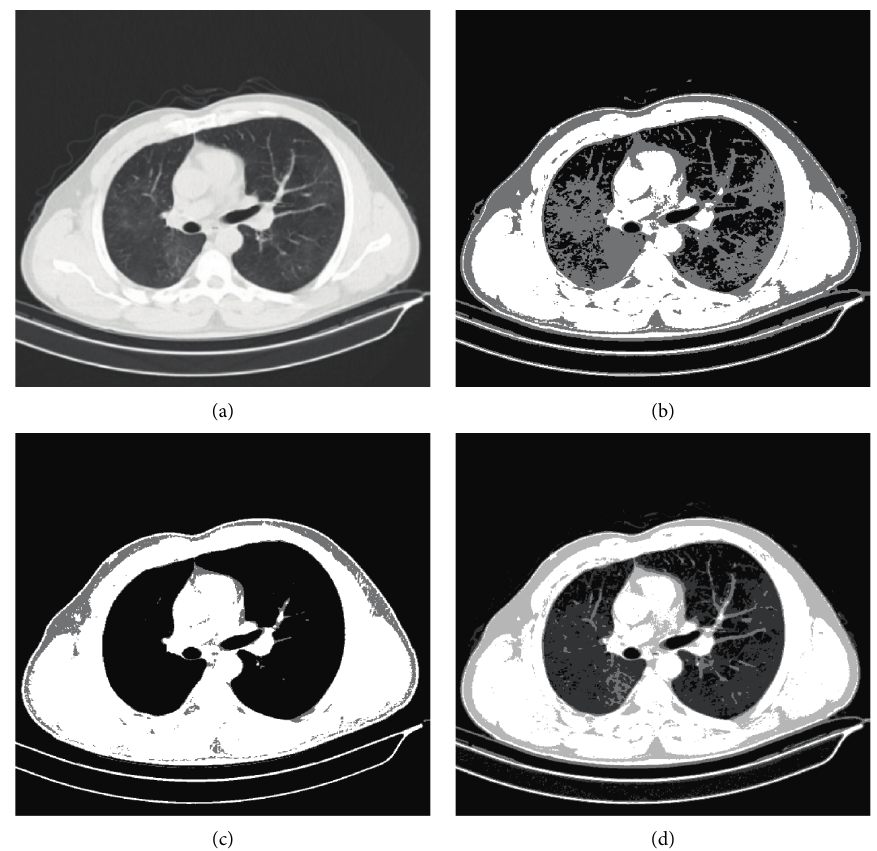
Figure 2: CT image-1 segmentation results of three threshold levels using the proposed approach. (a) Original CT image, (b) level-2 threshold segmentation, (c) level-3 threshold segmentation, and (d) level-4 threshold